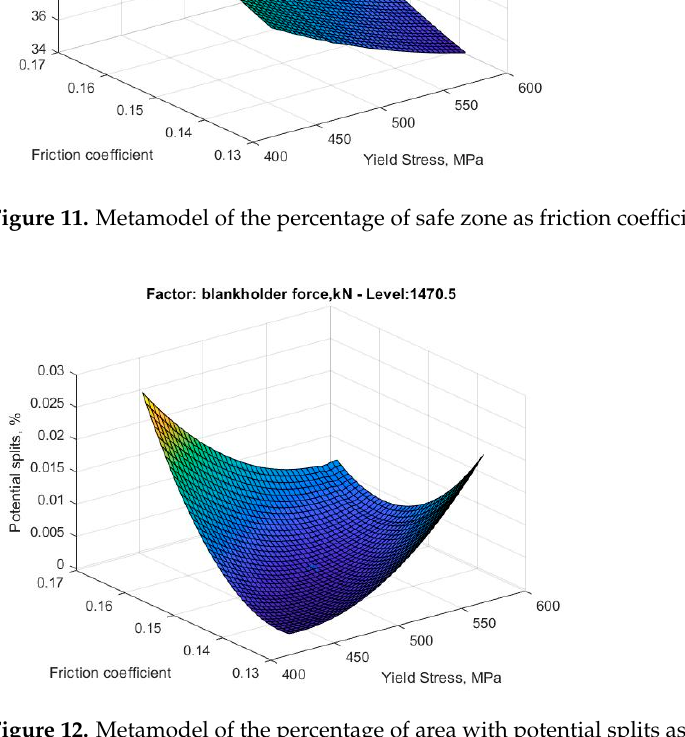
Figure 12. Metamodel of the percentage of area with potential splits as friction coefficient and yield stress vary.